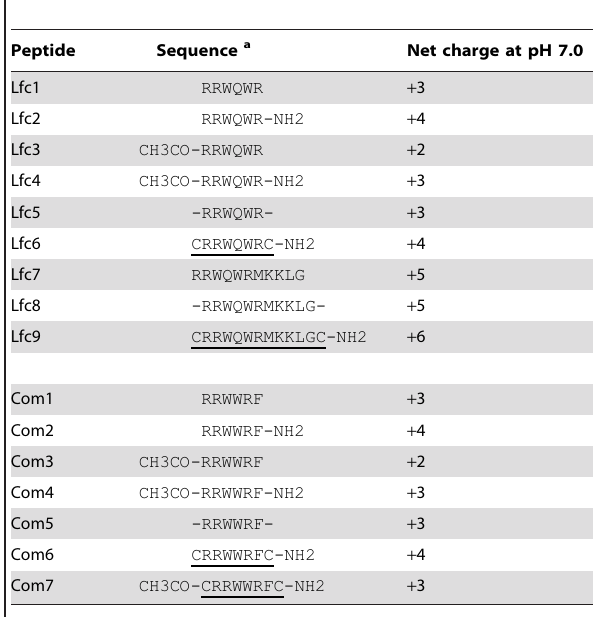
Table 1. Sequences and net charges of the short LfcinB and Combi